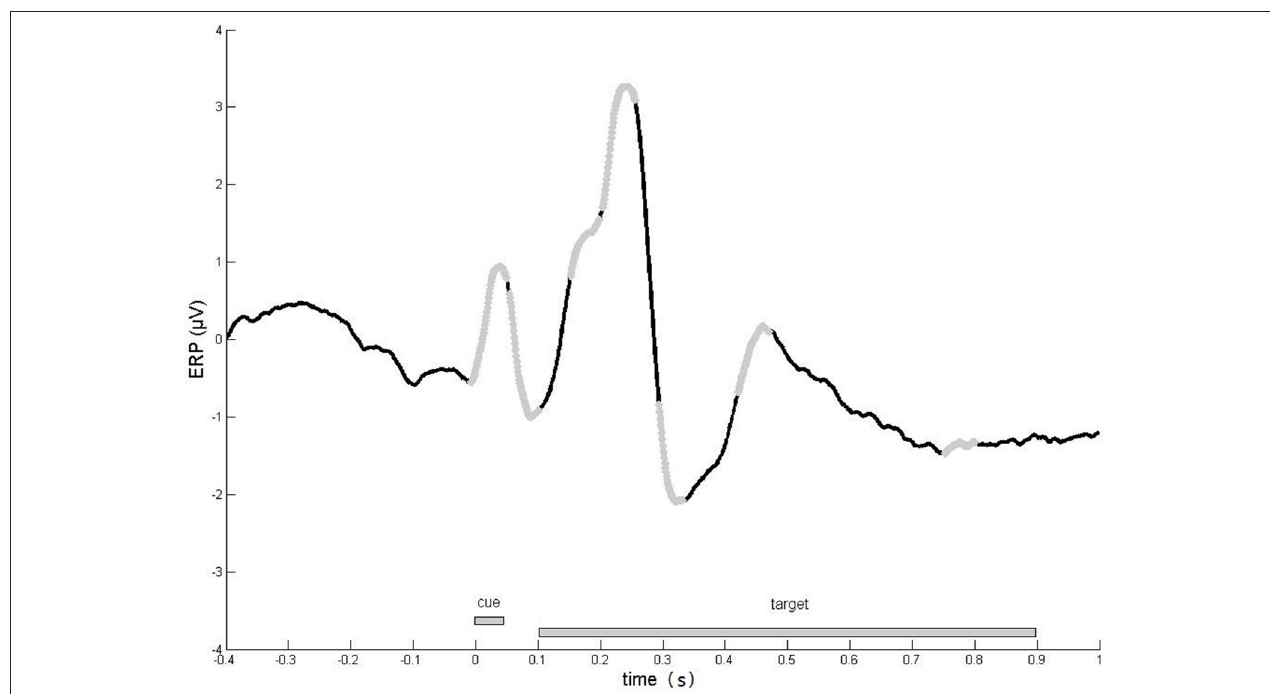
FIGURE 2 | Time course of evoked responses. Averaged evoked responses across all ERP sensors, experimental conditions and subjects. We focused our analyses on the time windows (light gray line), in which robust responses were